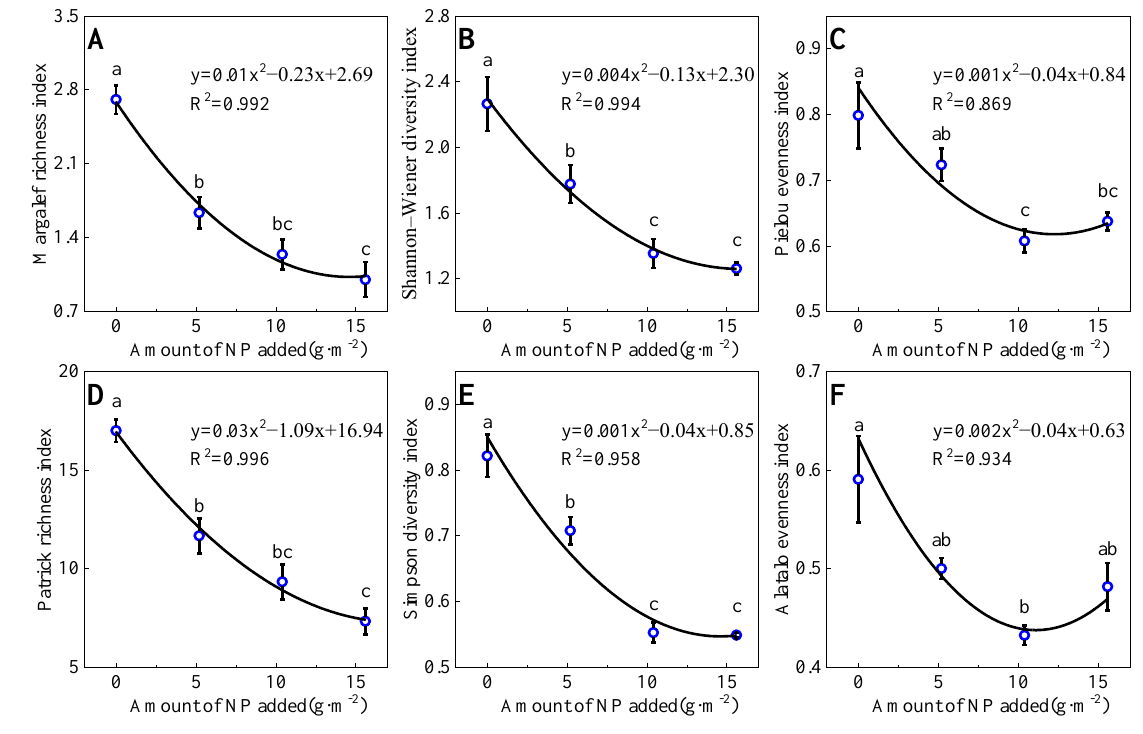
Figure 8. Changes in the species diversity index of L. chinensis meadow grassland communities after NP addition. ( A ) Margalef richness index, ( B ) Shannon–Wiener diversity index, ( C ) Pielou evenness index, ( D ) Patrick richness index, ( E ) Simpson diversity index, ( F ) Alatalo evenness index. The y function is the corresponding quadratic fitting equation, and R 2 represents the goodness-of-fit value. Lower case letters in the graphs indicate significant differences ( p < 0.05, LSD test).